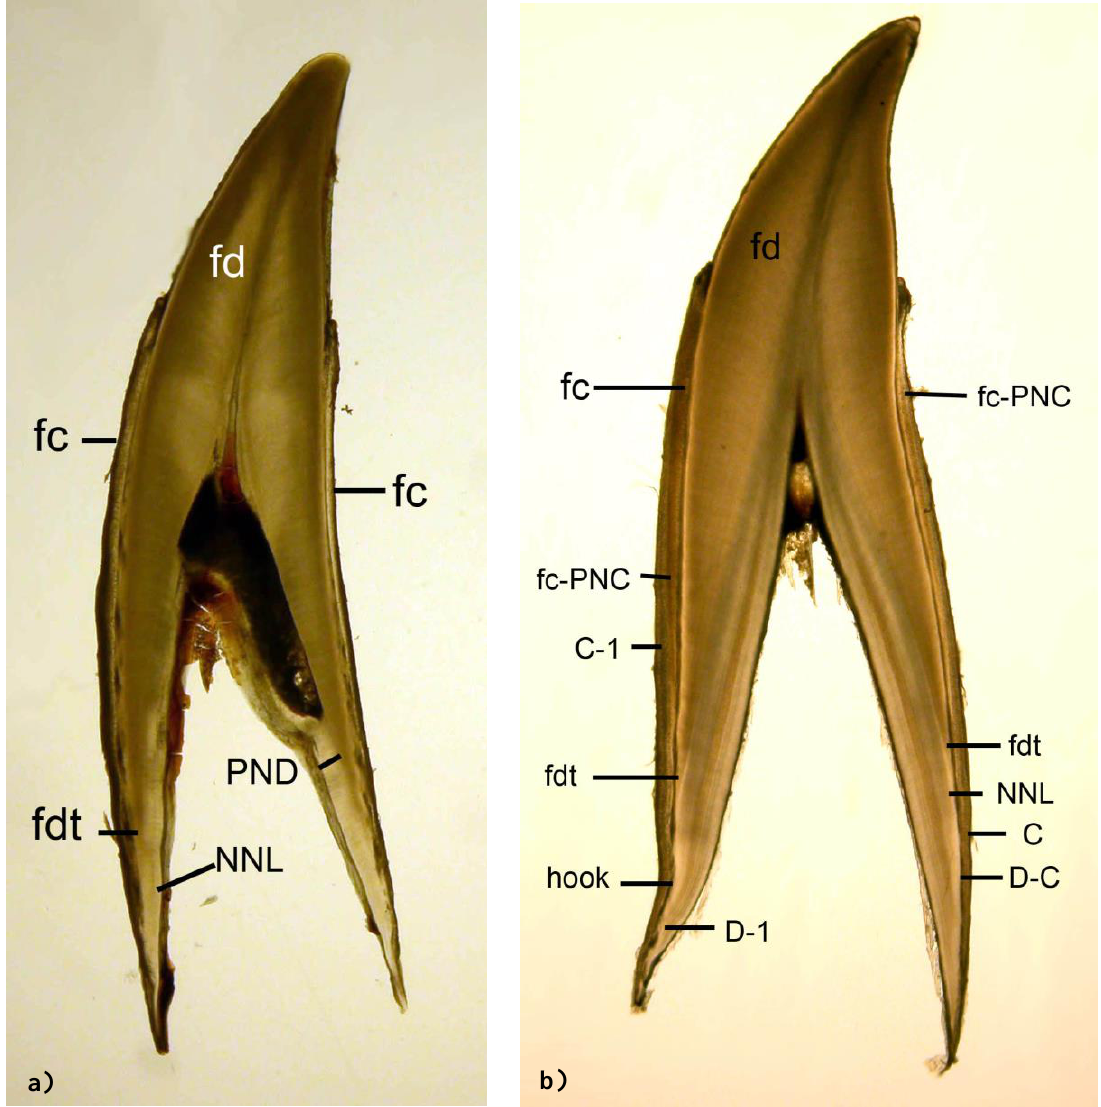
Fig. 4. Variation in neonatal lines and early postnatal growth layers. a) ARSQ-xx-1007, MNR- 2; young of the year. The fetal dentine terminus (fdt) marks the transition between fetal and postnatal dentine (PND). A faint neonatal line (NNL) may be developing. Fetal cementum (fc) is apparent but no postnatal cementum can be identified. b) PA05-20, MNR-5; approaching 1 year old. The neonatal line is ambiguous or missing altogether. A hook or fold at the dentine- cementum interface (D-C) represents the first extension of tooth length resulting from postnatal dentine deposition. The first, opaque dentine growth layer (D-1) enters the interface below the hook. The cementum (C) on the anterior face is most distinct: a short opaque band exists laterally at the fetal cementum-postnatal cementum interface (fc-PNC), at a level above the fetal dentine terminus (fdt); the first opaque cementum growth layer (C-1) tapers near the root and meets D-1 at